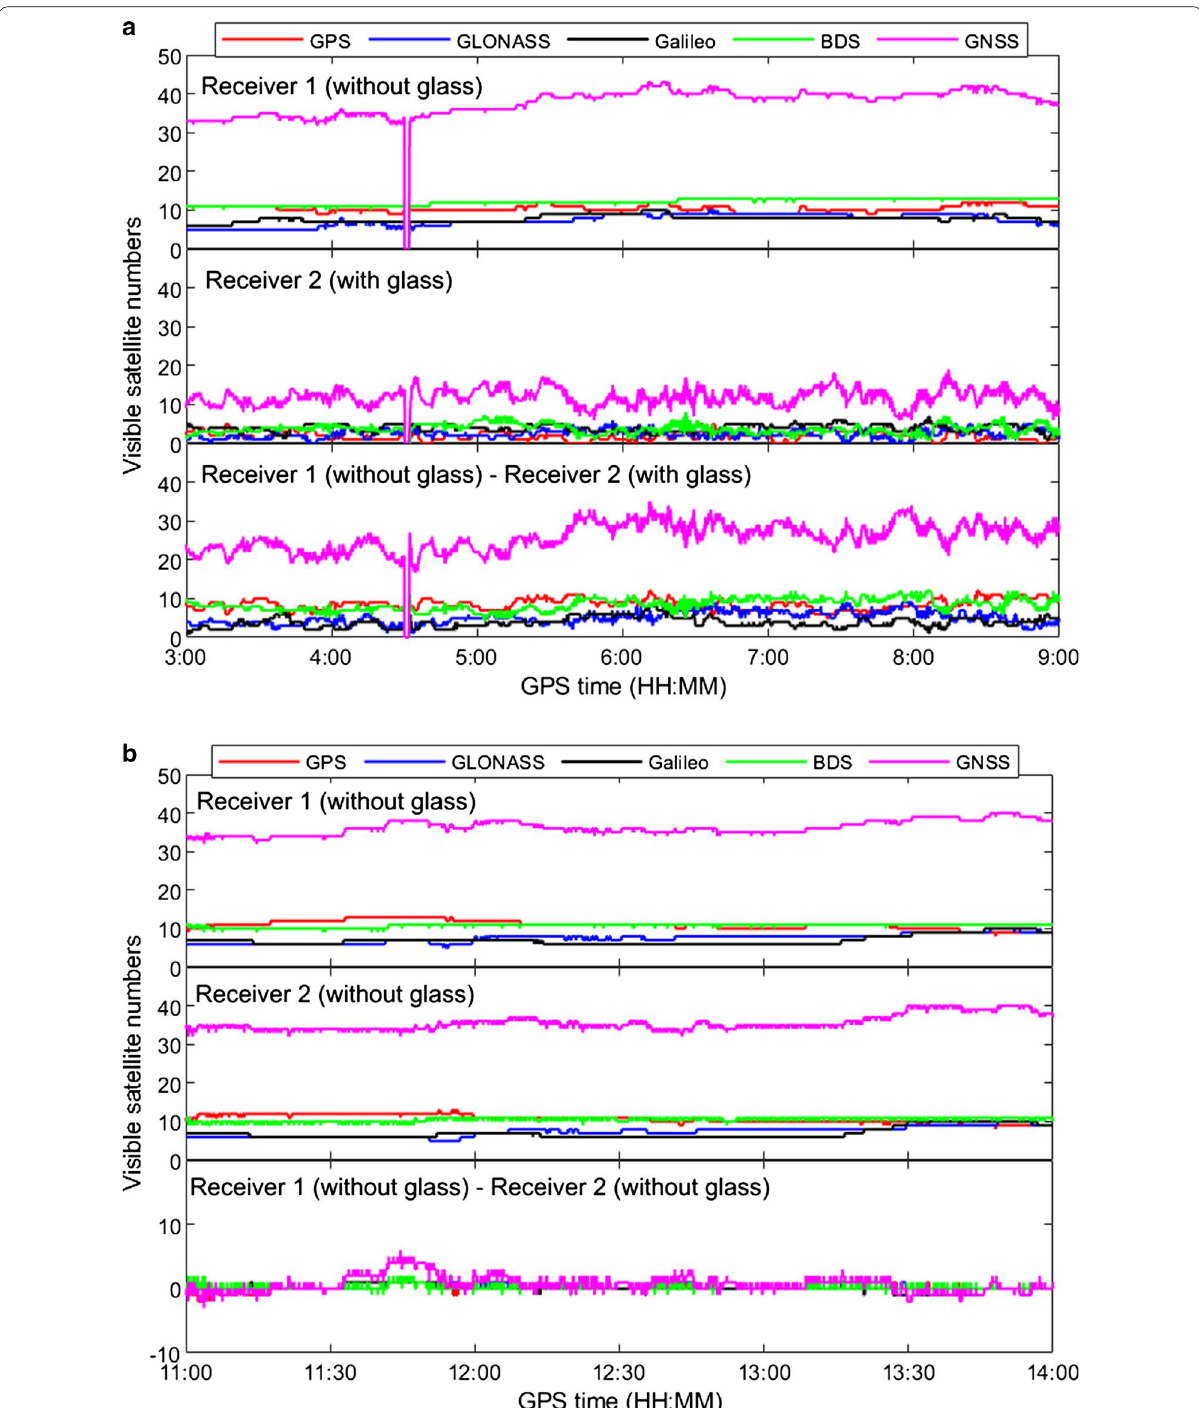
Fig. 5 Number of tracked GNSS satellites of two receivers during the two test periods. GNSS denotes a combination of GPS, GLONASS, Galileo, and BDS. a Number of tracked satellites of receiver 1 (without glass, top) and receiver 2 (with glass, middle) and their difference (bottom) during test period 1; b Number of tracked satellites of receiver 1 (without glass, top) and receiver 2 (without glass, middle) and their difference (bottom) during test period